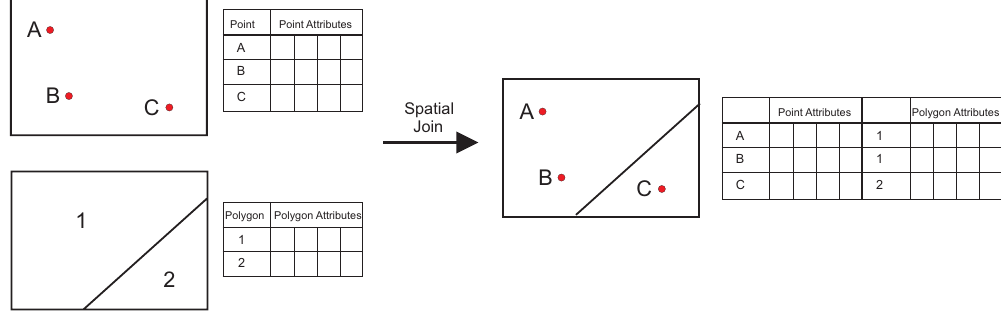
Fig. 8. Schematic illustrating the spatial join between a layer with three points and a second layer of two polygons. The process adds the attributes of the appropriate polygon that contains the point of interest. This is how we assign a geology to each heat flow measurement.